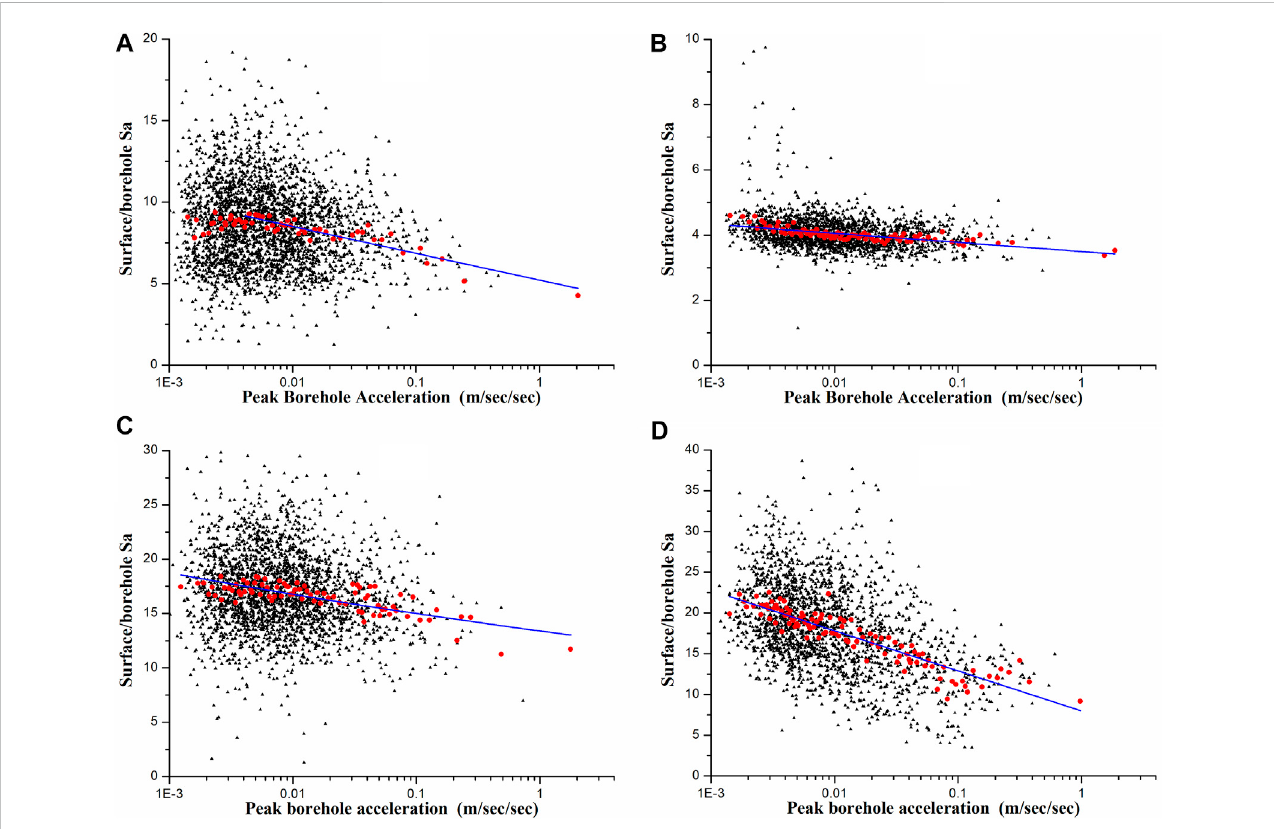
FIGURE 8 Thescatterdiagrams,theirsmoothedmeanvalues,andlinear fi ttingsfortheplatformvaluesofsurface/boreholeSaat (A) StationTCGH10onsiteclassI 1 ,